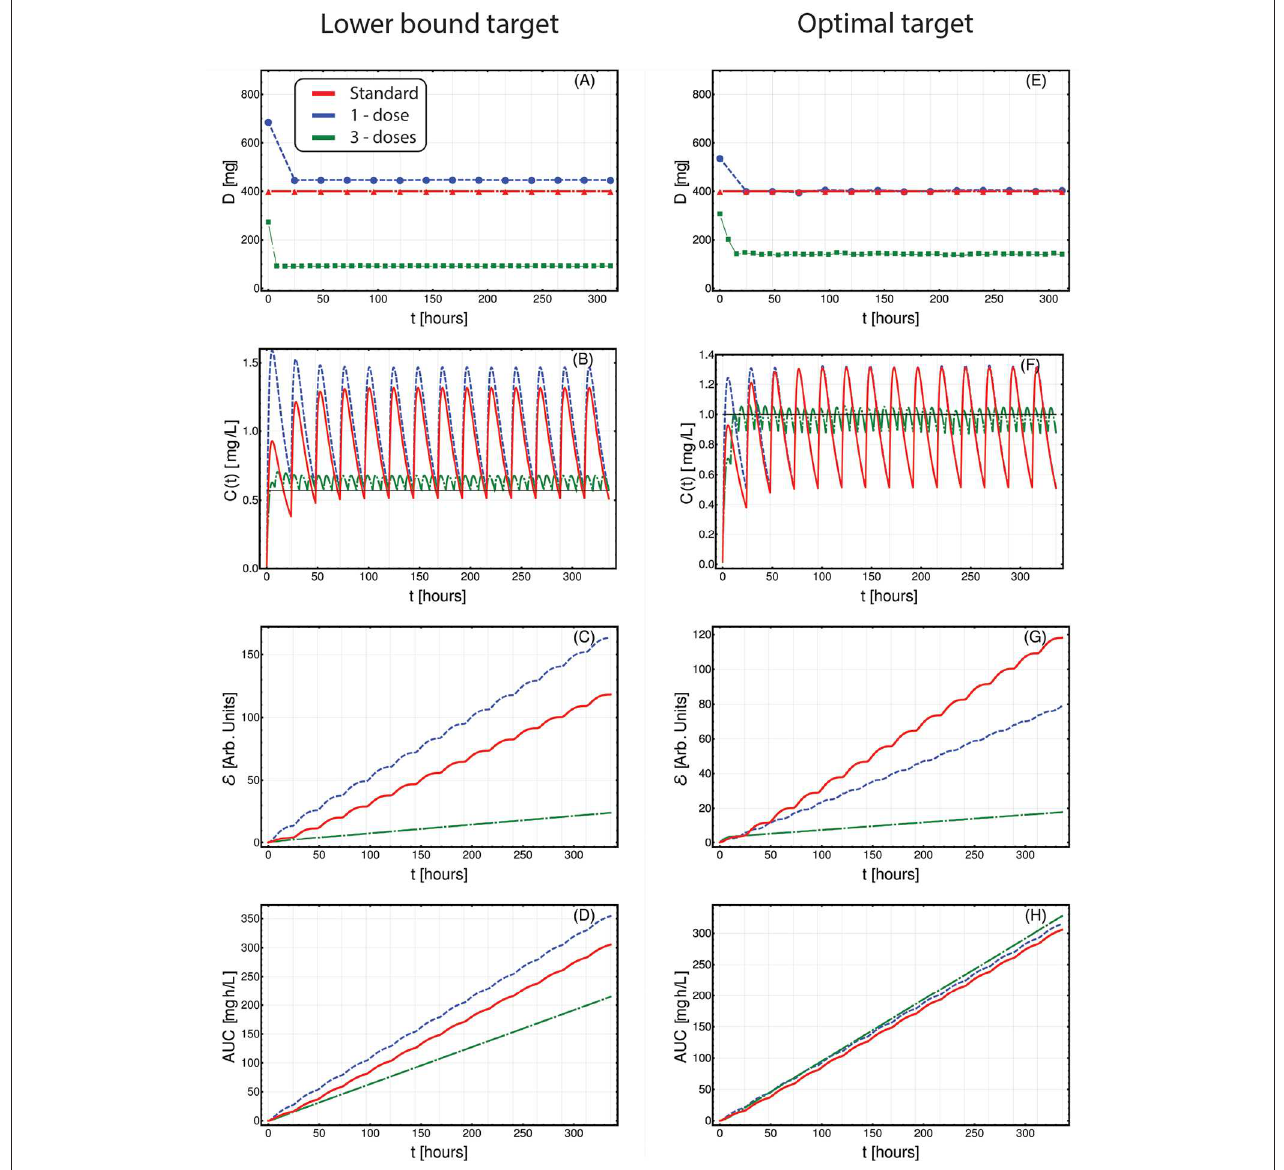
FIGURE 3 | Patient-specific optimized therapy with fixed target drug concentrations. Optimized Imatinib administration returned by CT4TD for patient 0001 00004 AJR from Michor et al. (2005), in the cases of: 1-dose/day (blue) and 3-doses/day (green), with respect to: lower-bound target concentration C targ = 0.57 [ mg / L ] (A–D) , and optimal target concentration C targ = 1 [ mg / L ] (E–H) . Standard administration—i.e., 400 mg Imatinib/day—is shown with a red dashed line. In this case, the optimization is obtained on patient-specific PK parameters, without considering the PD models. (A,E) Imatinib scheduled dosage in mg (y axis), displayed on 14 days (x axis). (B–F) Imatinib concentration in blood in [ mg / L ] (y axis). (C–G) Variation of the cumulative distances between the observed concentration and the selected target in time. (D–H) Temporal variation of the AUC in [ mg · h / L ].